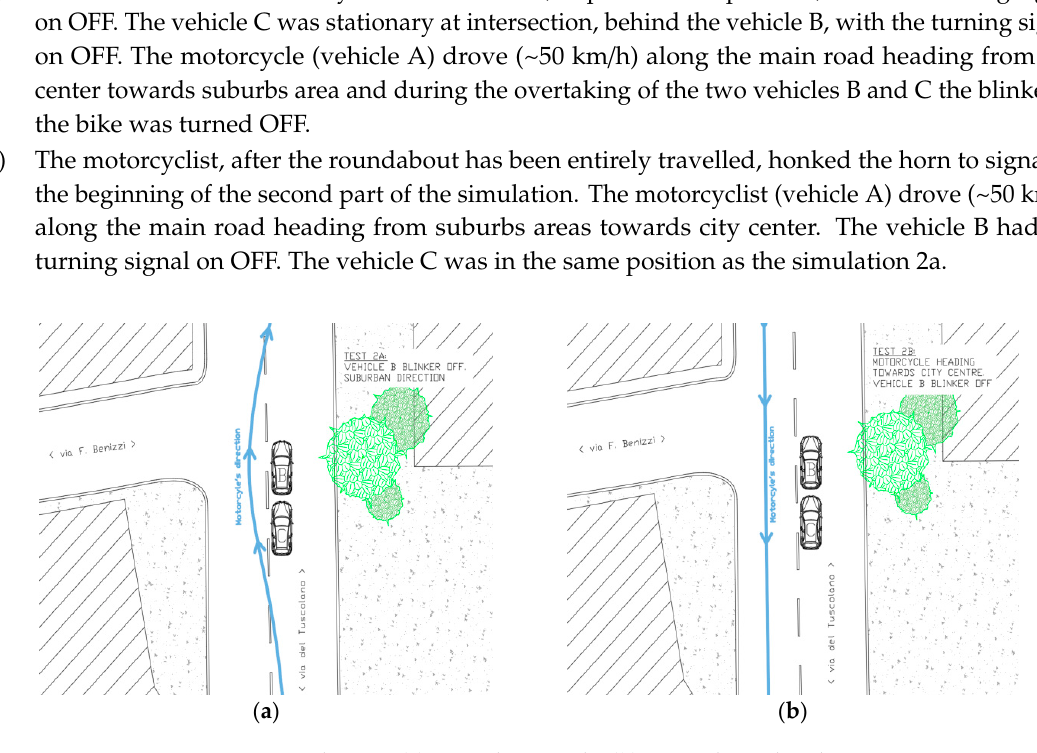
Figure 4. Simulation 2( a ) overtaking, and 2( b ) going through, schemes.